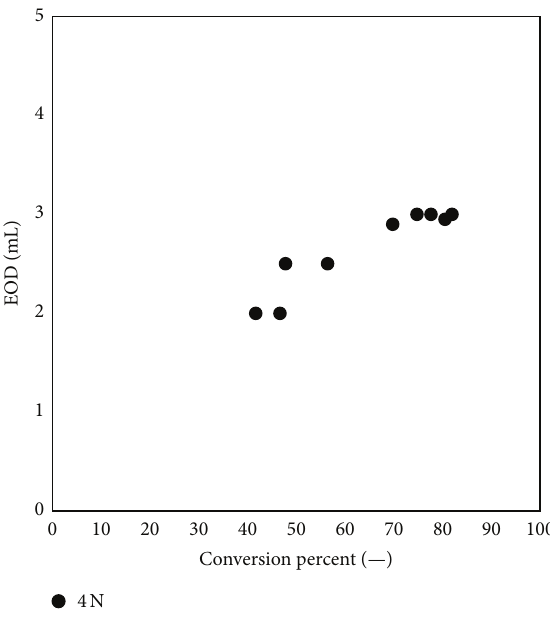
Figure 6: Electroosmatic drag (mL) versus conversion (—).